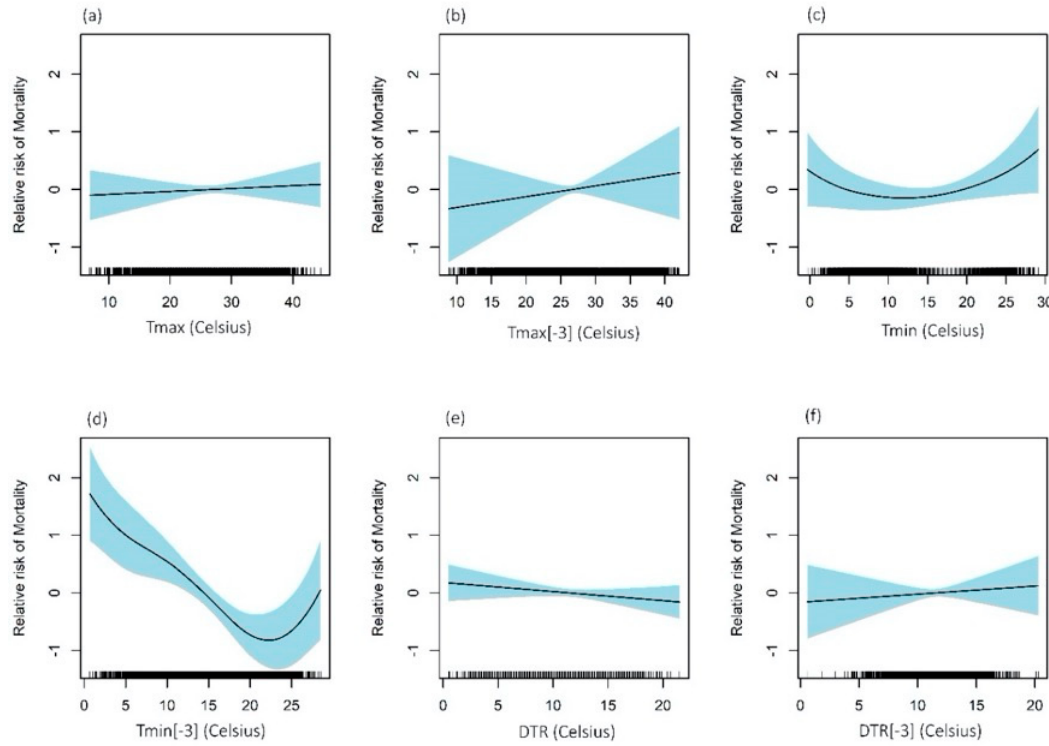
Figure 2. Temperature–mortality relative risk functions for Nicosia, Cyprus, 2004–2014. T max , T max [–3], T min , T min [–3], DTR, and DTR[–3] are shown in ( a – f ), respectively.